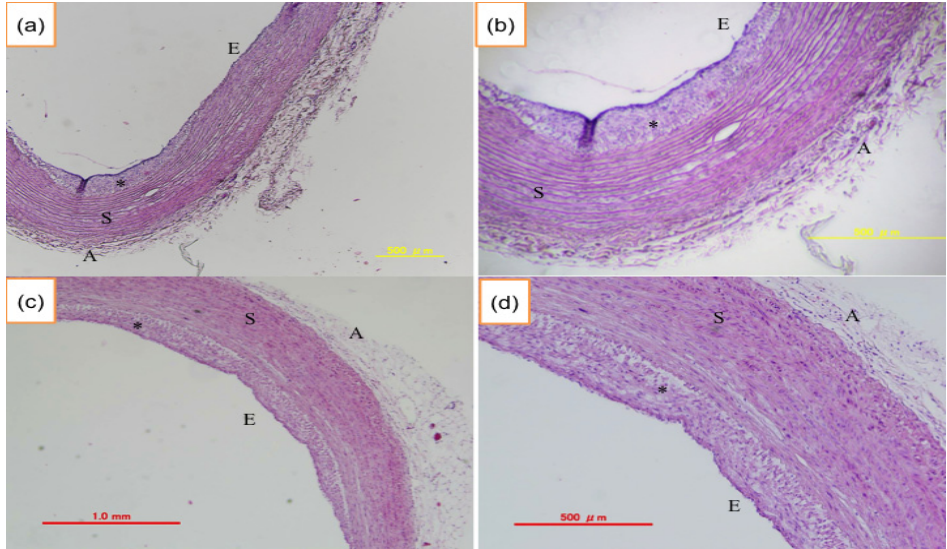
Figure 8. Atherosclerotic changes in PHT aorta. ( a , b ) aorta from 12-month-old PHT rabbit; ( c , d ) aorta from 33-month-old PHT rabbit. E: endothelium, S: smooth muscle, A: adventitia, * indicates atherosclerotic intimal thickening. ( b ) and ( d ) are enlarged pictures of ( a ) and ( c ),